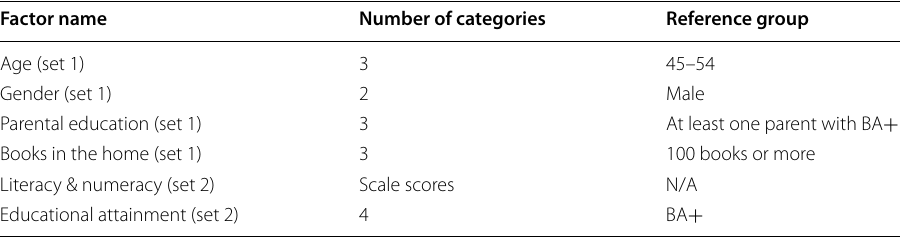
Table 1 Factors employed in analyses, the number of categories corresponding to each factor and the reference group used in regression analyses (if appropriate). Adapted from Braun